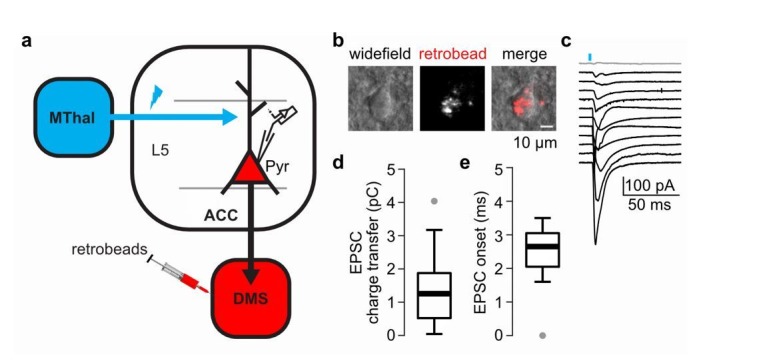
The DMS-projecting L5 pyramidal neurons in the ACC receive direct inputs from the MThal.(a) Experimental schematic showing retrogradely-transported beads (retrobeads) injection in the DMS to retrogradely-label DMS-projecting pyramidal neurons (Pyr) in the ACC, and AAV2/1-CAG-ChR2(H134R)-tdTomato injection in the MThal to allow for optical stimulation of specific thalamic inputs to the ACC. (b) Representative brightfield (left panel) and fluorescent (center panel) images of an ACC layer 5 (L5) with retrobeads present in the soma (merge, right panel). (c) Averaged optically-evoked excitatory postsynaptic currents (EPSCs, average of 12 single trials) of all individual bead-positive L5 pyramidal neurons recorded in the DMS/MThal injected mice (n = 12 neurons from 4 mice). 11 out of 12 recorded cells (black traces) received inputs from the MThal, defined as peak amplitude > (mean baseline + 5 x standard deviation). Grey trace: non-responding L5 pyramidal neuron. Blue bar: 1 ms of 470 nm light stimulation. (d) Quantification of the EPSC charge transfer of all recorded EPSCs as shown in B. (e) Quantification of EPSC onset time of all recorded EPSCs as shown in B. Box plot with median, first and third quartile and whiskers represent 1.5 times interquartile range.